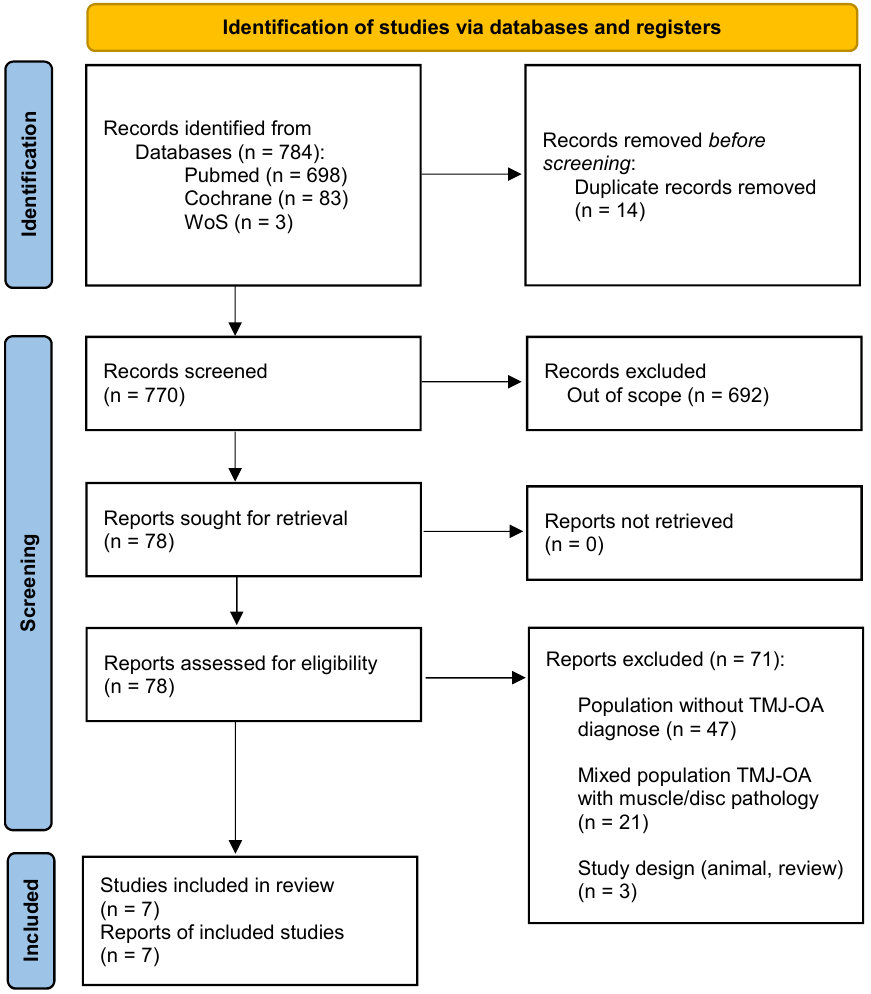
Figure 1. PRISMA flow